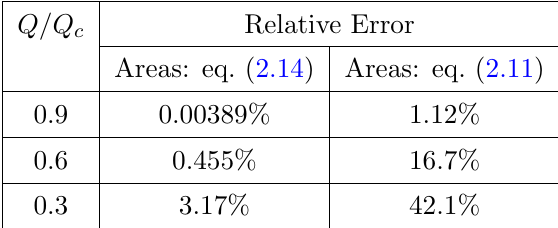
Table 3 . Comparing the Accuracy of the errors given by Equations (2.14) and (2.11). We have computed the relative error on the T / M plane between the areas de(cid:12)ned by each equation. Due to the areas being de(cid:12)ned by (2.14) being much larger, their relative error is less accurate than between the relative error between the areas of interest de(cid:12)ned by (2.11).